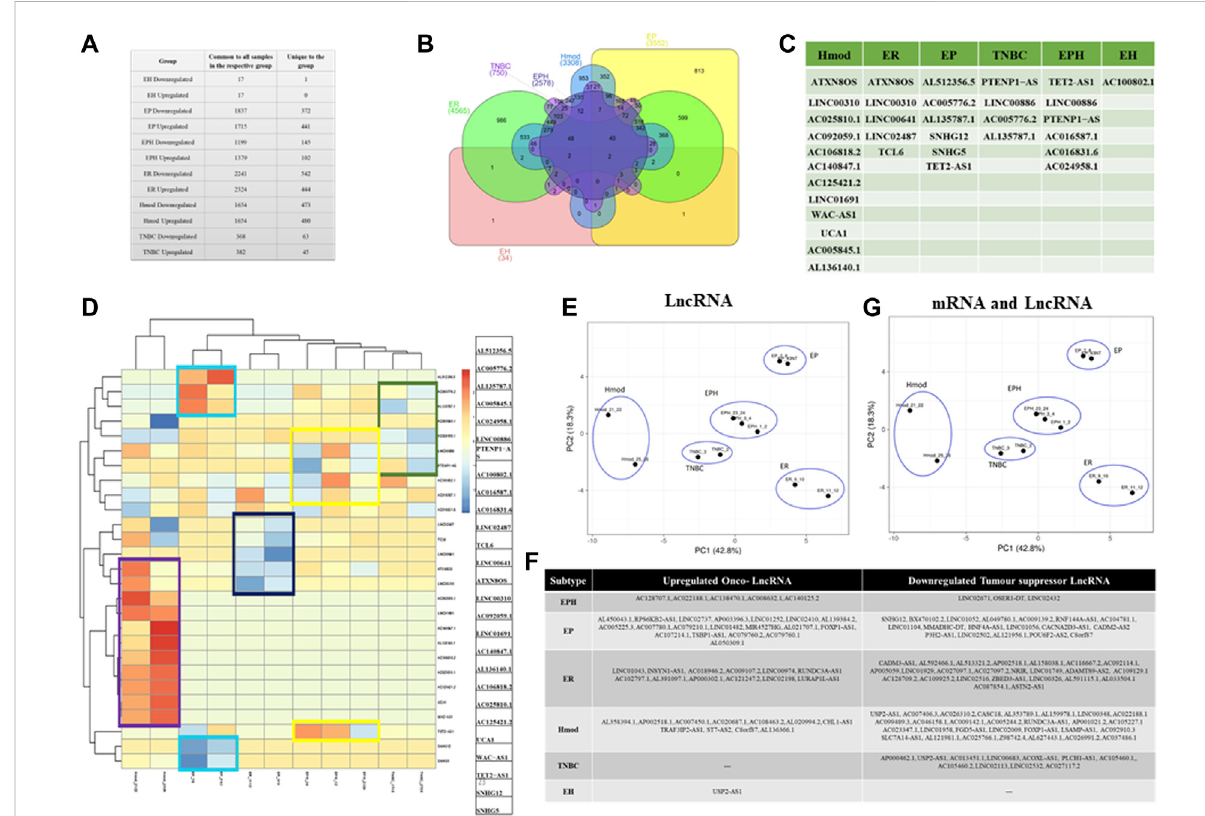
FIGURE 5 (A) Table showing the number of differentially expressed lncRNAs that are common to all patients in a subtype and unique lncRNAs when compared to other subtypes of breast cancer. (B) Venn diagram showing common and unique lncRNAs among different subtypes of breast